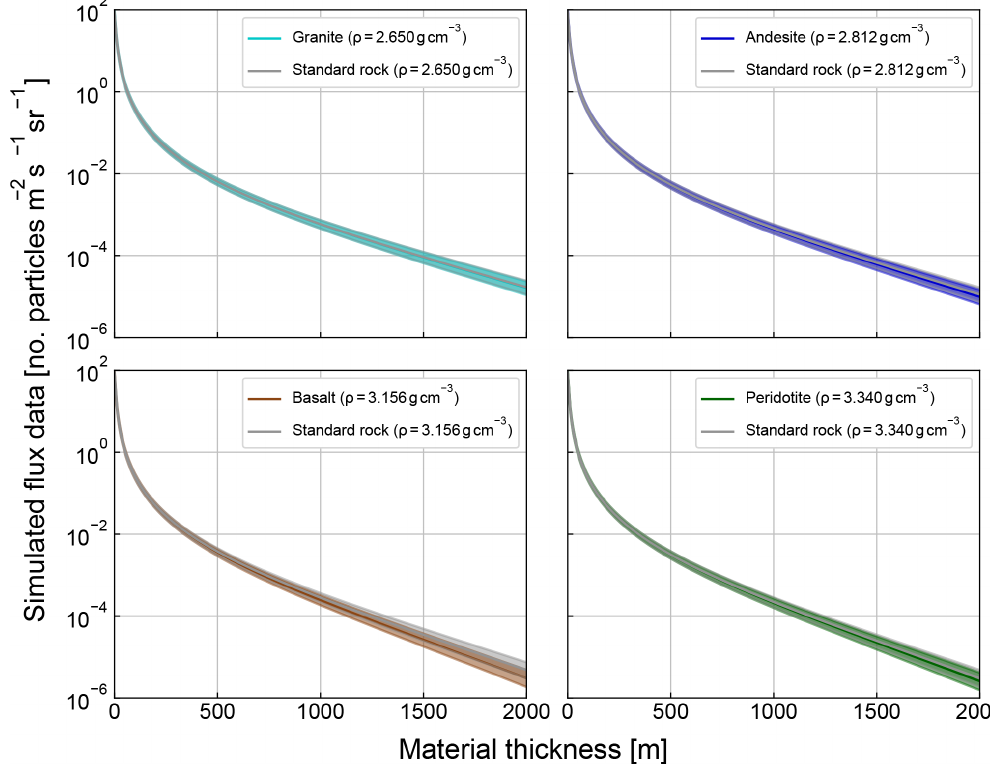
Figure 5. Simulated muon intensity vs. thickness of the four igneous rocks from Table 1 and a density-modified standard rock. The mean flux is indicated by a bold line and 1 σ bounds are indicated by the shaded